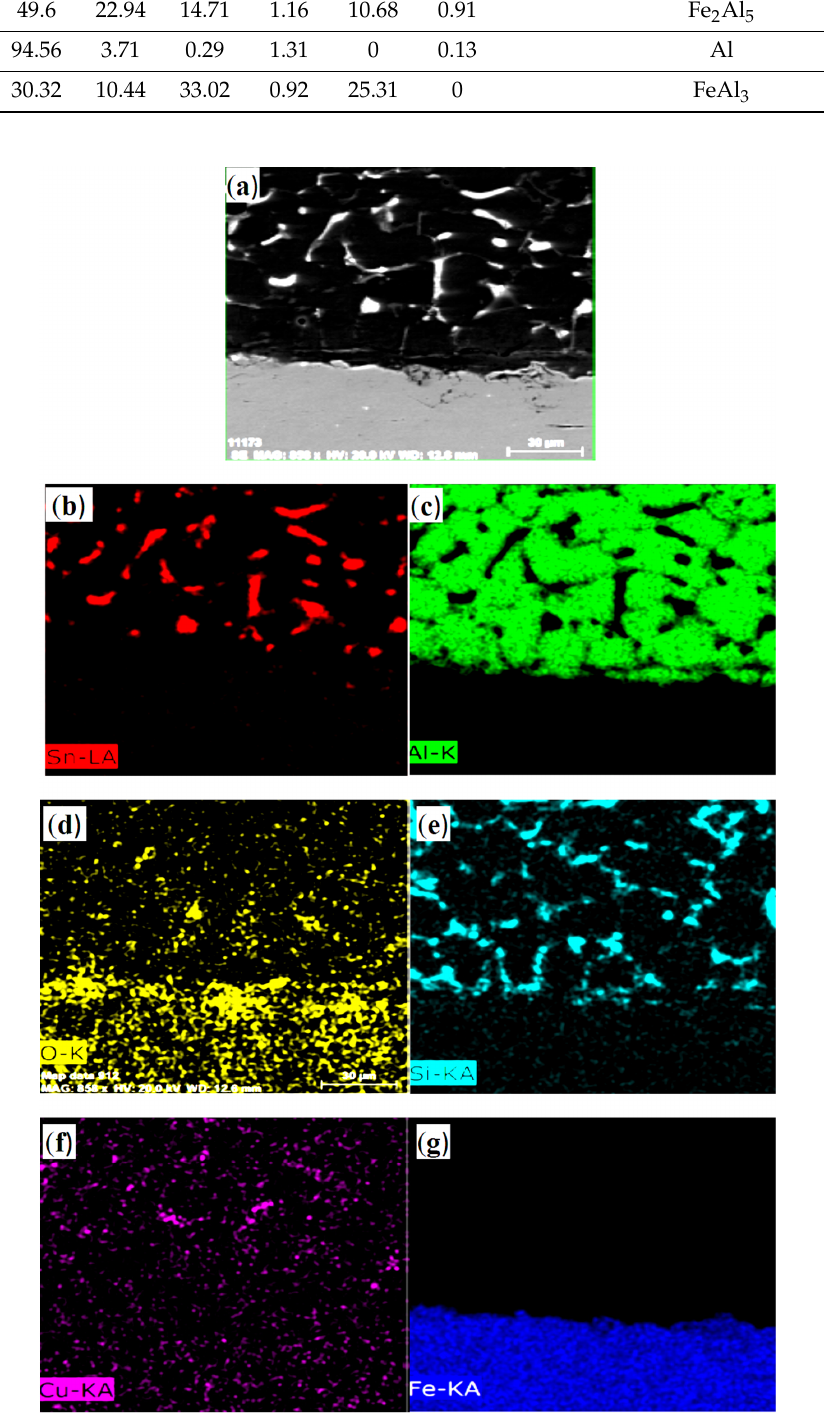
Figure 7. SEM image ( a ), and mapping analysis ( b – g ) of bimetallic materials containing a tin:flux ratio of 1:15.